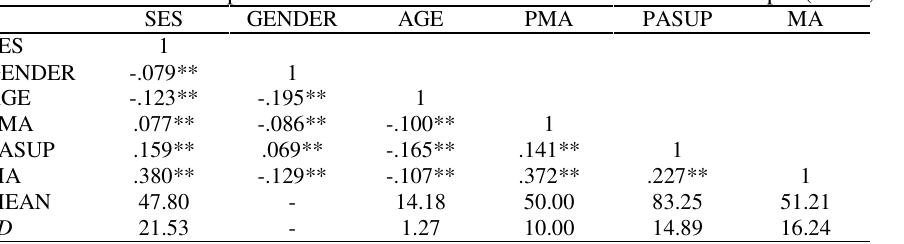
Table B1 Student-level predictors and mathematics achievement for total sample ( N = 4,768)